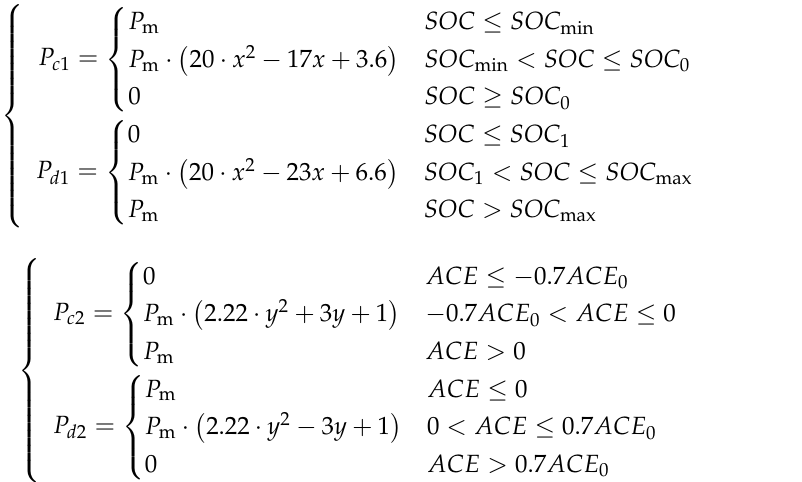
Figure 3. Diagram of output restrictions in self-recovery of energy storage. The self-recovery power demand of energy storage and constraint curve of the power grid’s frequency control system in Figure 3 obtain the control law of self-recovery action for the BESS, as shown in Equations (15) and (16).